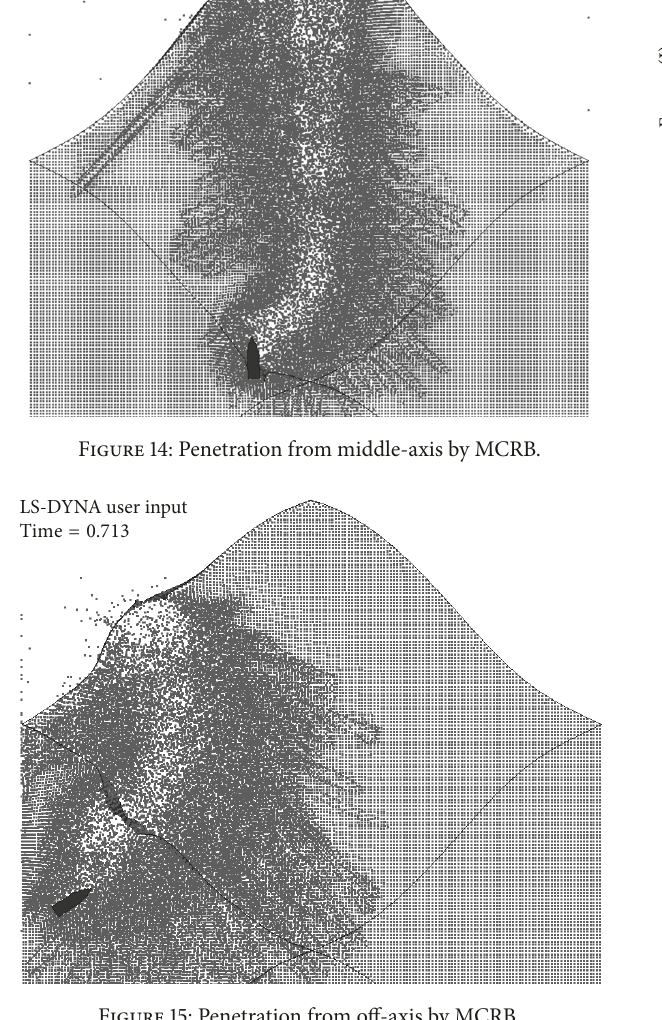
Figure 15: Penetration from off-axis by MCRB.